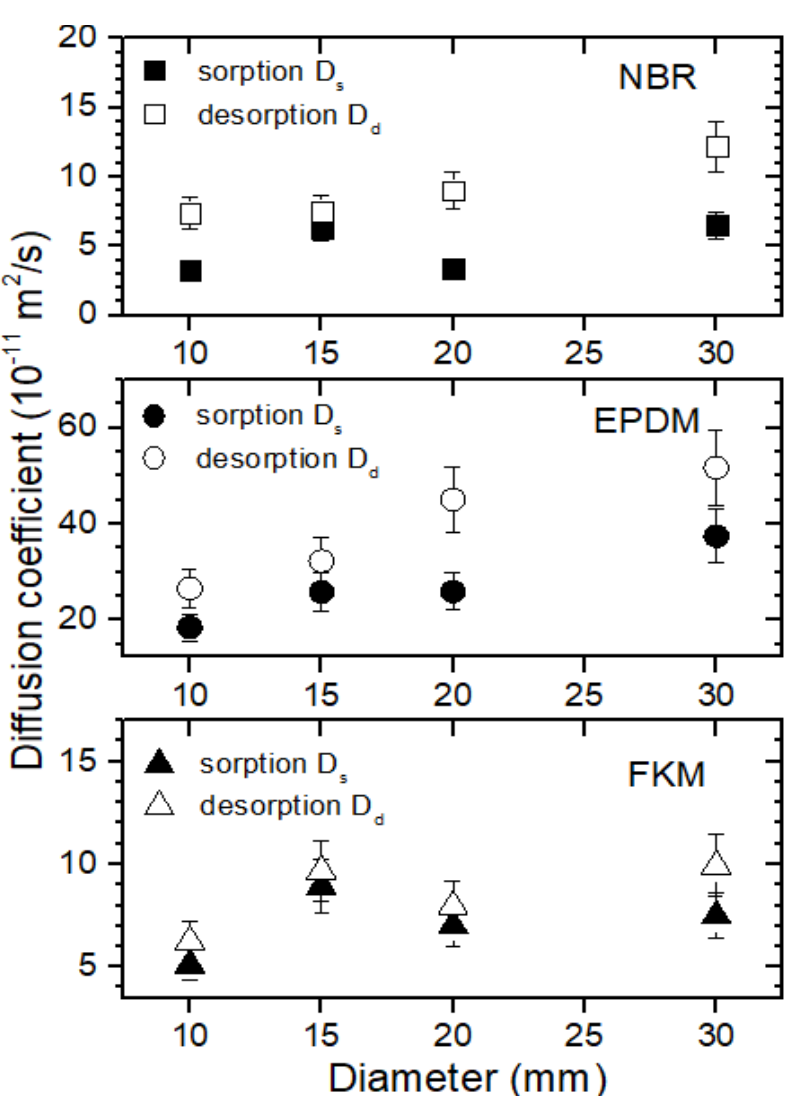
Figure 5. Comparison of the diffusion coefficient ( D s ) in the sorption and diffusivity, D d , in the desorption versus specimen diameter for spherically-shaped NBR, EPDM, and FKM.